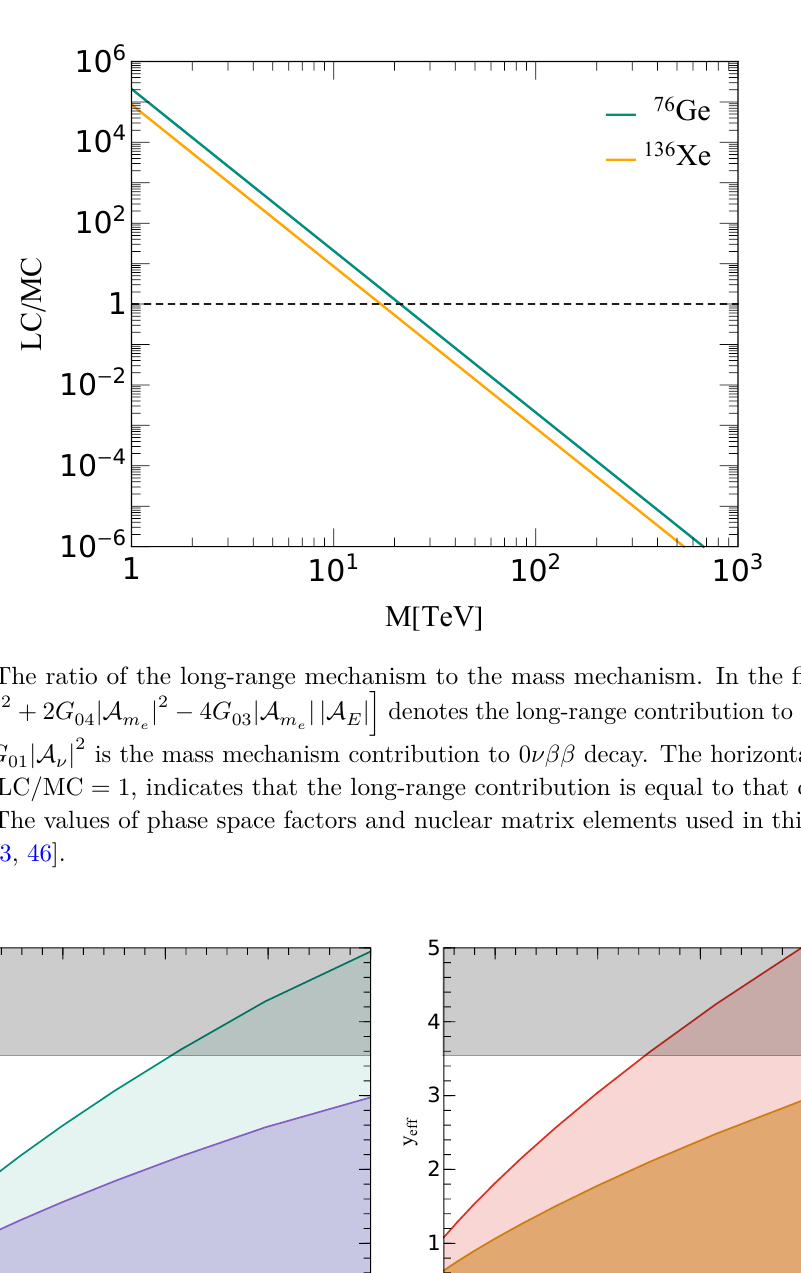
and new particle mass M by the 0 νββ eff √ ≤ 4 π eff